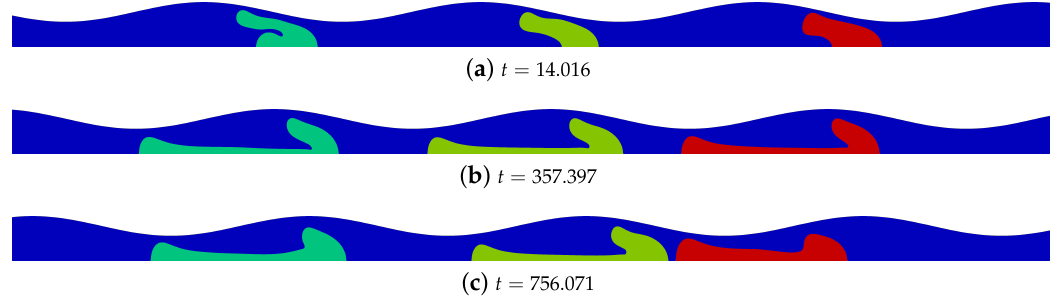
Figure 7. Drops shape evolution with time in sinusoidal channel with amplitude A = 0.14 and initial liquid slug length s = 1.875. The rear drop is green color, the center drop yellow, and the front drop red. The center drop is affected by the presence of the front and rear drops, thus simulating a complex slug flow. Drop coalescence is noted between the front and center drops in time t c = 757.822. All parameters are